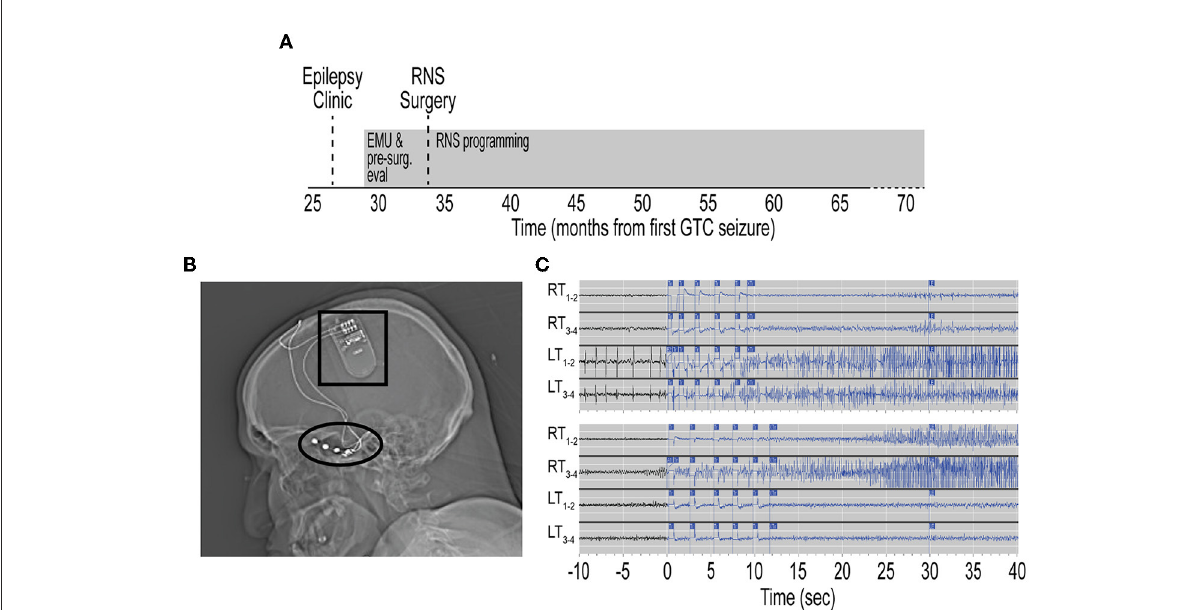
FIGURE2 Treatment timeline with RNS placement and temporal lobe seizure capture. (A) Timeline from initial referral for evaluation in Epilepsy clinic, pre-surgical evaluation, and RNS surgery. Timeline depicted from first GTC seizure. Evaluations and RNS programming designated by gray rectangles. (B) Sagittal head computed tomography scan showing RNS generator (black box) implanted in right frontal skull. Two 4-contact subtemporal lobe strips are implanted bilaterally (black oval). (C) Top, representative electrocorticography (ECoG) demonstrating left temporal lobe onset seizures. Time scale represents seconds from RNS seizure detection. Traces show seizure detection in LT1–2 and LT3–4 subtemporal contact. Bottom, representative ECoG demonstrating in right temporal lobe onset seizures. RNS, responsive neurostimulator; EMU, epilepsy monitoring unit; GTC, generalized tonic-clonic; RT, right temporal; LT, left temporal; Tr,